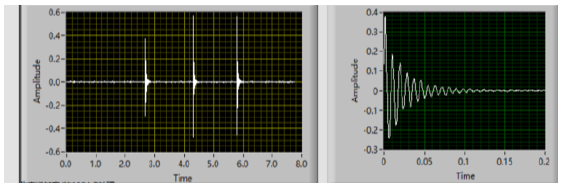
Figure 3. Time-magnitude signal as the acceleration response signal.